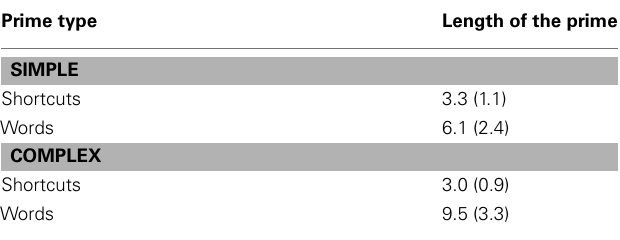
Table 1 | Prime characteristics: average length of the prime (number of characters, SDs in